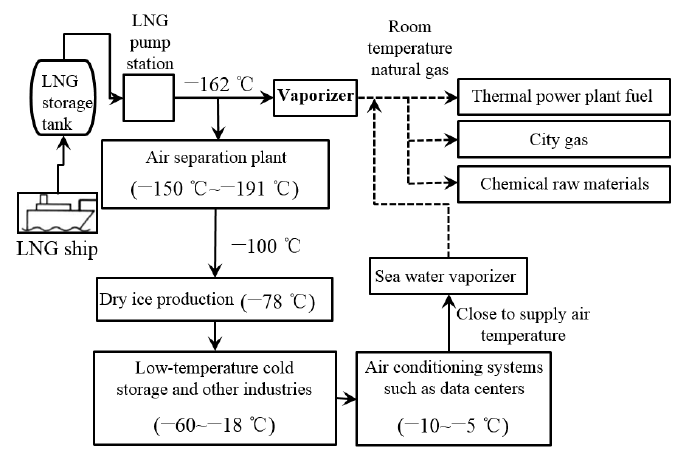
Figure 12. LNG cold energy cascade utilization flow chart.